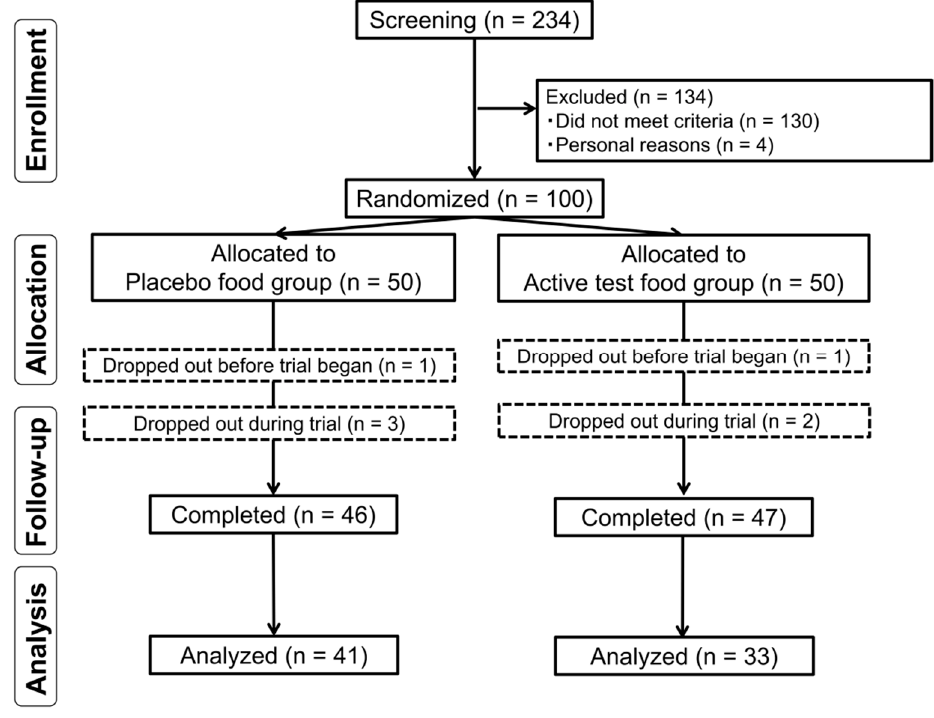
Table4. Characteristicsofsubjectsandintakeratesoftestfoodsintheactivetestfoodandplacebogroups. Table 4. Characteristics of subjects and intake rates of test foods in the active test food and placebo groups. Characteristic Placebo Active Characteristic Placebo Active p Subjects, n